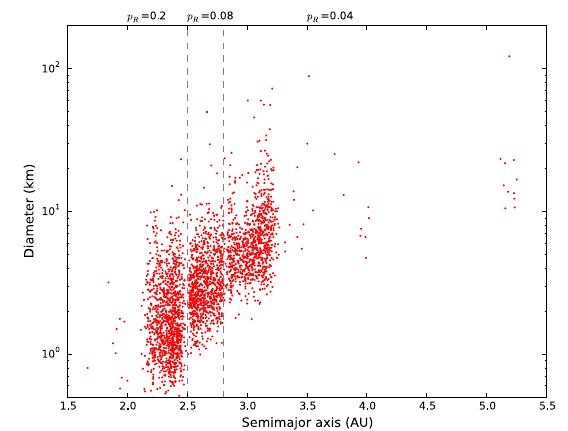
Fig. 2 Diameter vs. semi‑major axis of the PTF‑U2s. Most of the PTF‑ U2s are main‑belt asteroids. Because of the limiting magnitude (i.e., 14 to 21 mag), the diameter range changes with semi‑major axis. ∼ ∼ The albedo values adopted in the diameter calculations are indicated in the plot. This figure is reproduced from Chang et al. (2015,